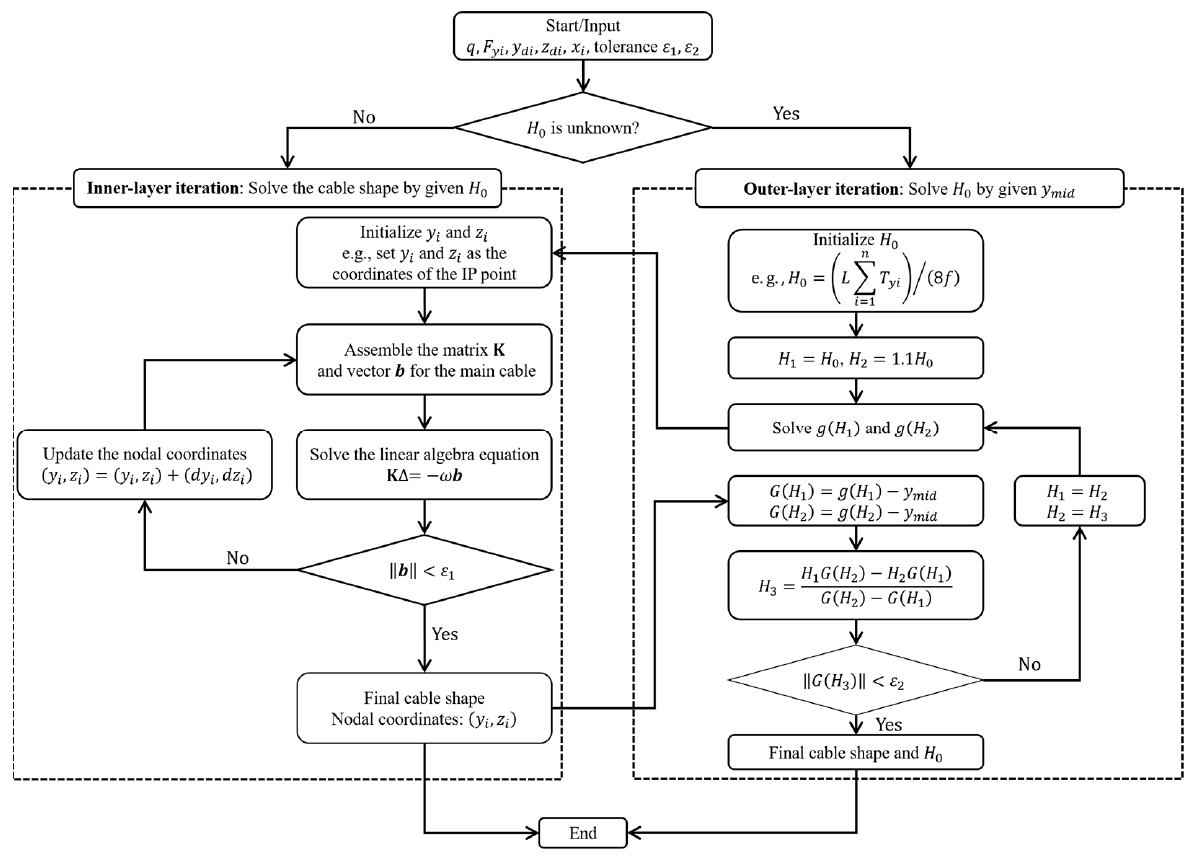
Figure 2. Flowchart of the iteration scheme for solving the cable shape.